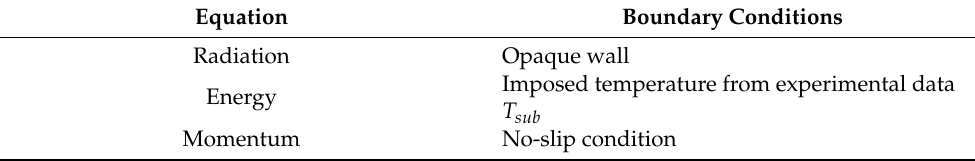
Table A6. Greenhouse soil and substrate surface.